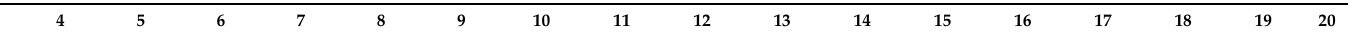
Table 5. Correlation between the Internet activities and problematic usage of the Internet (Spearman